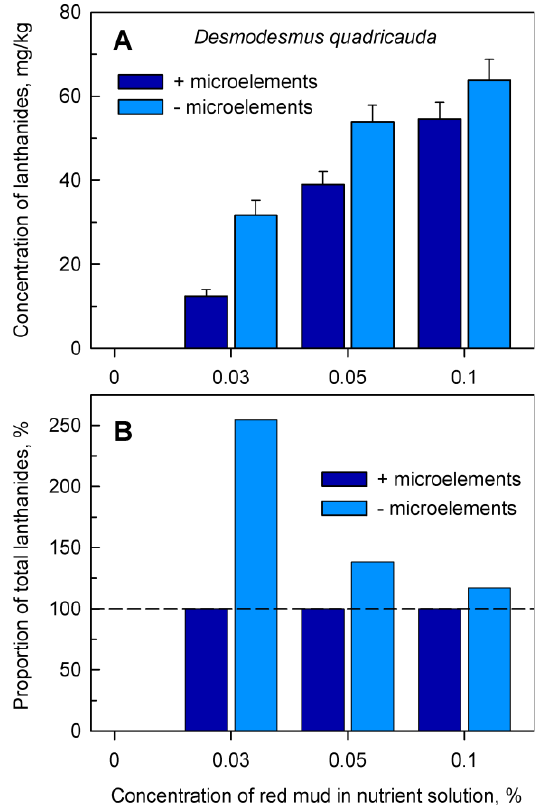
Figure 5. Total amount of accumulated lanthanides in Desmodesmus quadricauda cells ( Panel A ) after 48 h of growth in the absence (0%) or in the presence of different concentrations (0.03, 0.05, 0.1%) of red mud, either in complete nutrient medium (+microelements) or in medium without added microelements (-microelements). Panel B : Proportion of total lanthanides in cells grown in nutrient medium without added microelements normalized to the content of lanthanides in cells grown in complete nutrient medium (set to 100%, highlighted by dashed horizontal line).